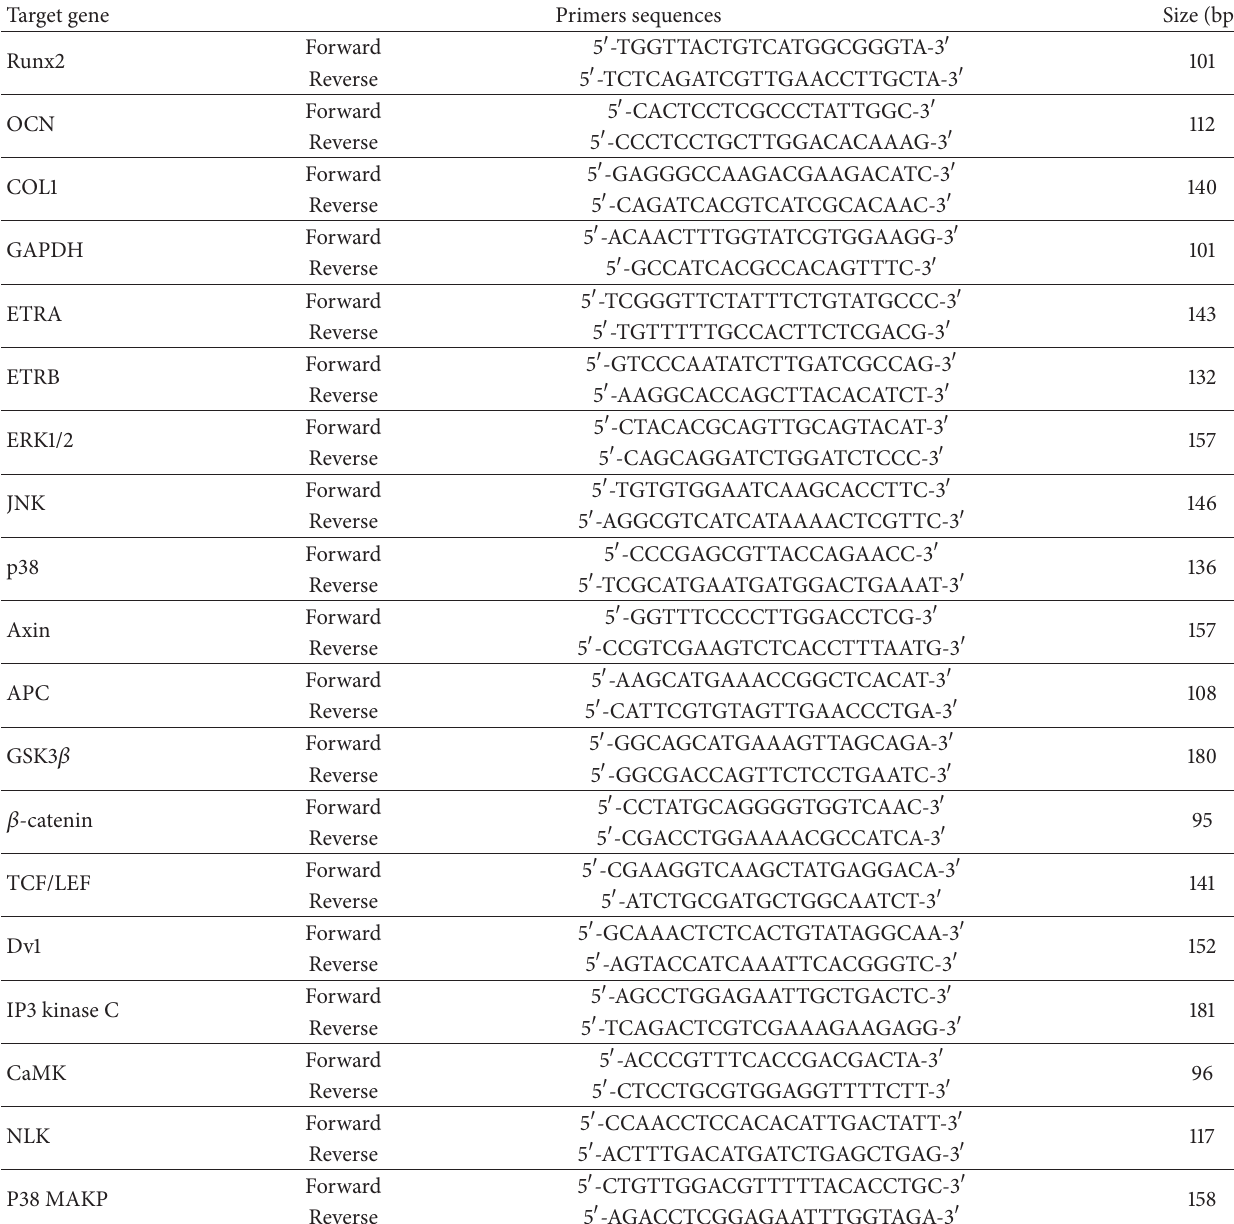
Table 1: The human primer sequences used for real-time